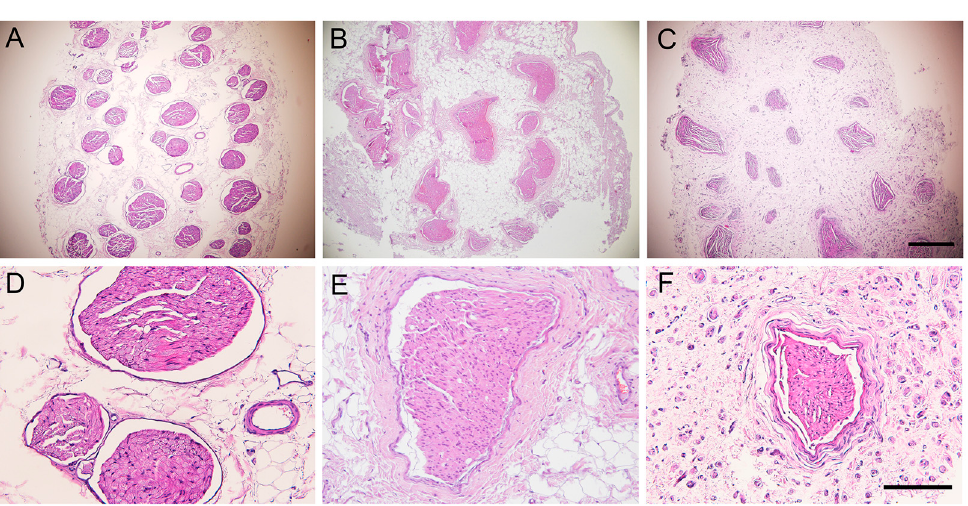
Figure 4. Representative micrographs of cross-sections of the middle part of the nerve graft stained with hematoxylin and eosin. ( A , D ) control nerve, ( B , E ) nerve of a sheep of group AG5, and ( C , F ) of group AG7, viewed at 40× magnification ( A – C ), scale bar 500 μ m, and at ×200 magnification ( D – F ), scale bar 150 μ m.